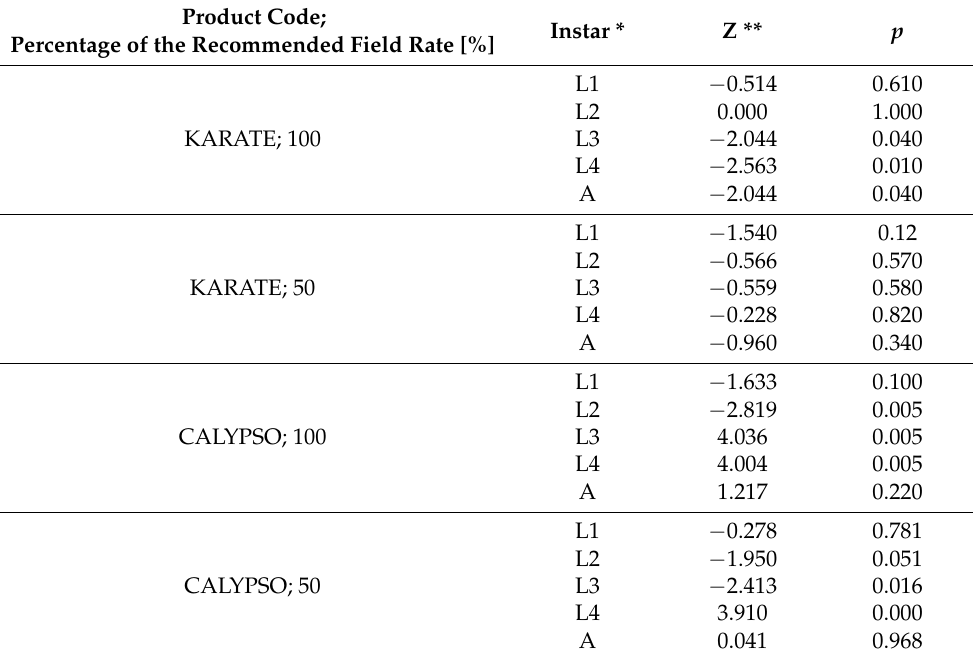
Table 1. Significance of differences between survival dynamics of Harmonia axyridis and Coccinella septempunctata after their foraging on insecticide-treated prey. Product